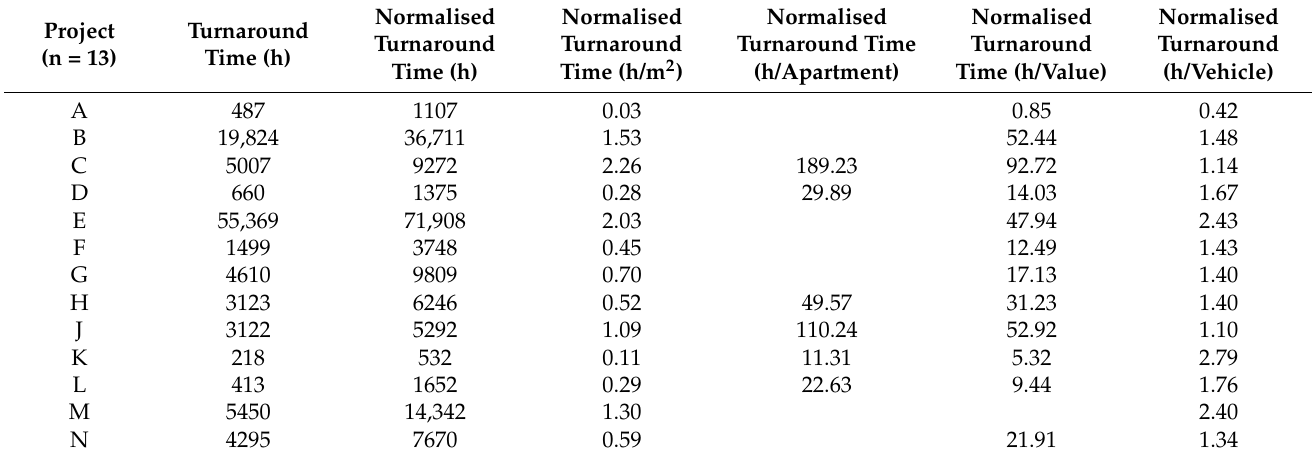
Table 4. Turnaround times for